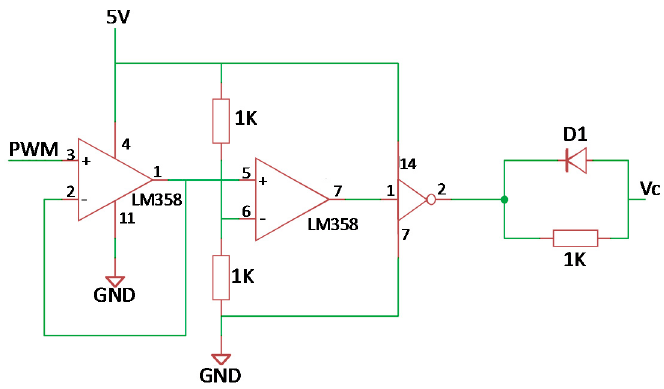
Figure 11. Schematic diagram for conditioning the PWM signal from the Arduino board.